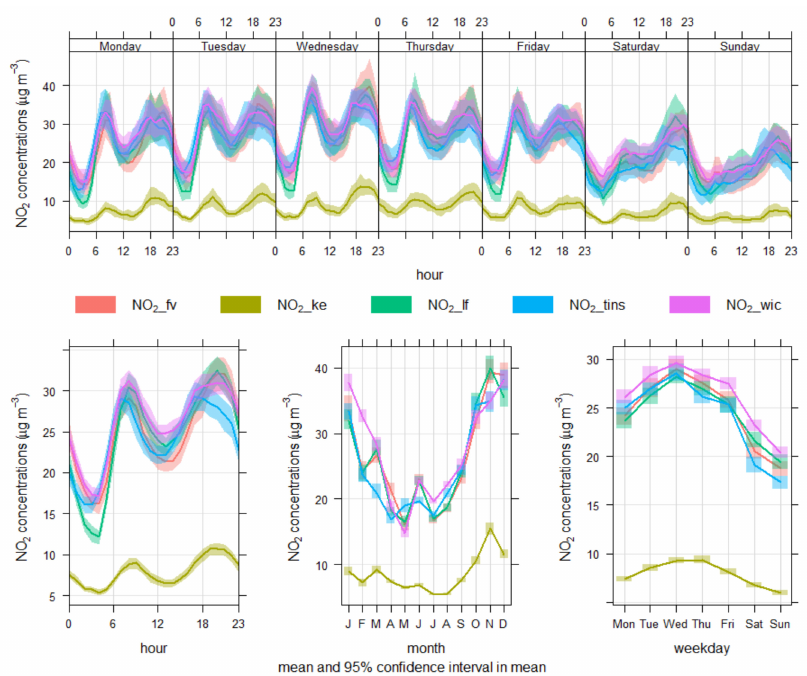
Figure 10. Time variation plots of NO 2 concentrations ( µ g/m 3 ) measured at SCC sites: Firvale, King Ecgbert, Lowfield, Tinsley and Wicker, from August 2019–September